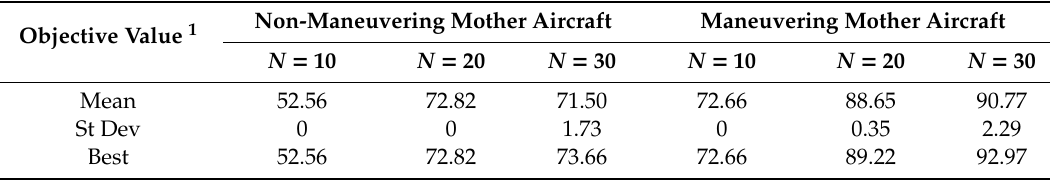
Figure 12. Distances from the UAVs to the mother aircraft. ( a ) 10 UAVs with a non-maneuvering mother aircraft; ( b ) 10 UAVs with a maneuvering mother aircraft; ( c ) 20 UAVs with a non-maneuvering mother aircraft; ( d ) 20 UAVs with a maneuvering mother aircraft; ( e ) 30 UAVs with a non-maneuvering mother aircraft; ( f ) 30 UAVs with a maneuvering mother aircraft. Table 6. Results of the Monte Carlo